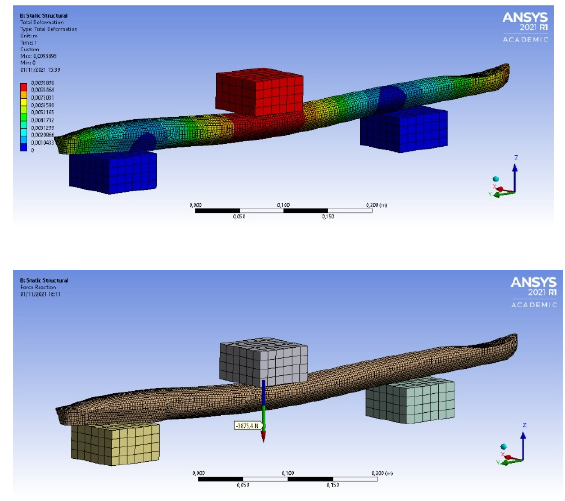
Figure 14. HexMC (displacement 2.55 mm, resulting force 5251.4 N) .